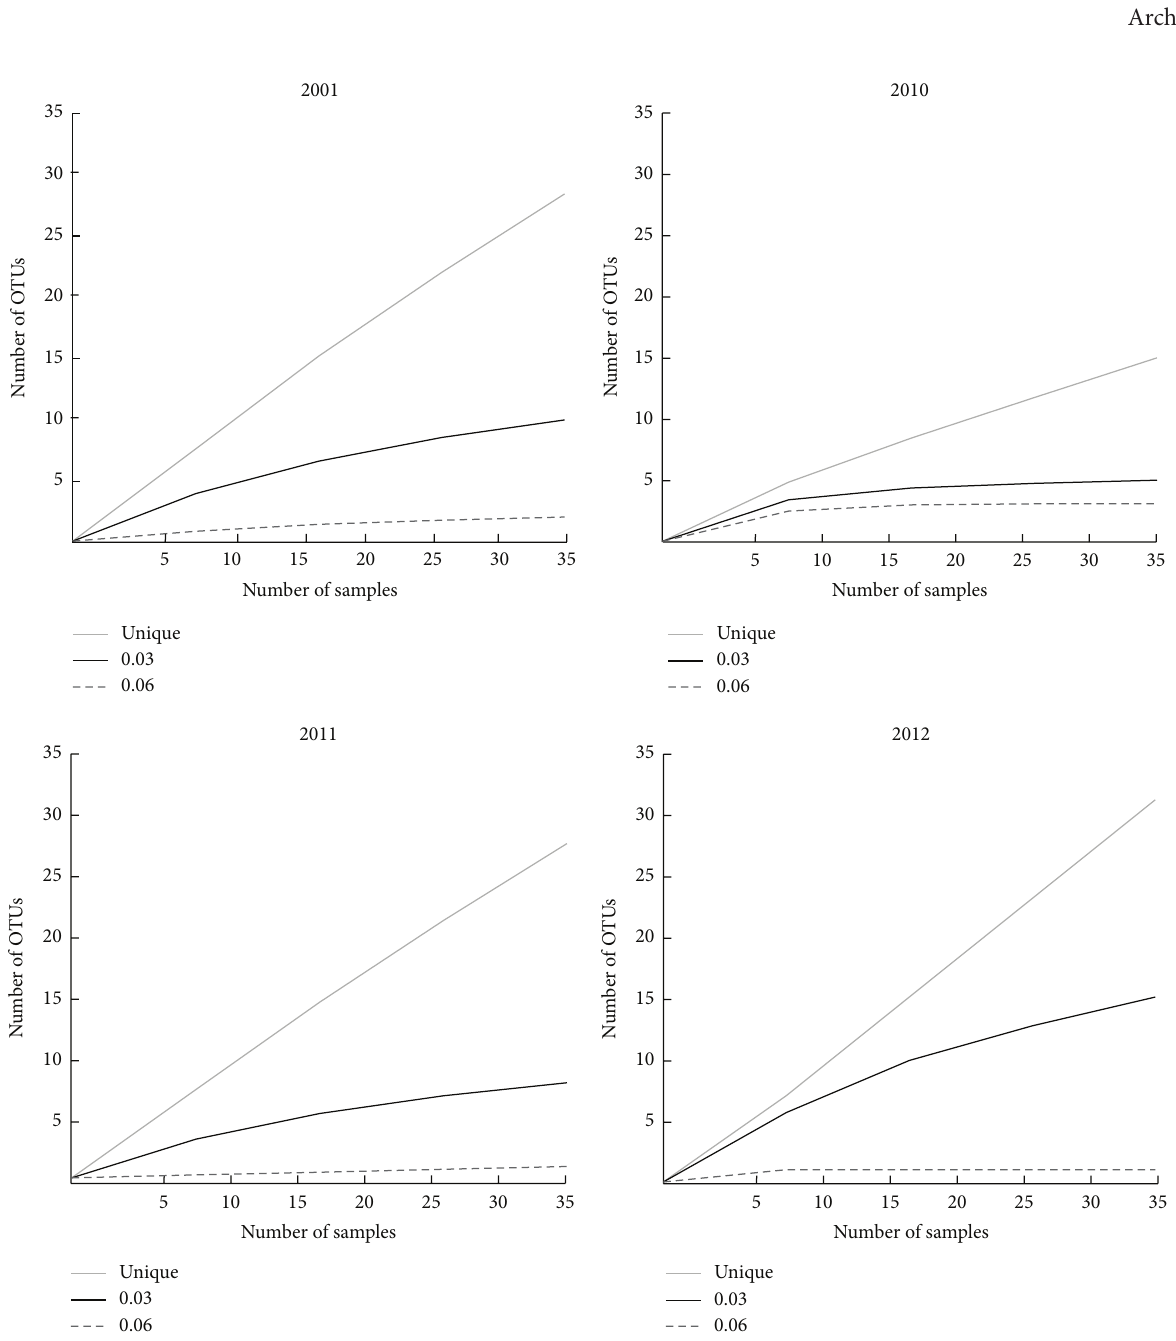
Figure 3: Rarefaction curves of 16S rRNA gene clone libraries from Stone’s Pocket. The y -axis is number of different OTUs, and the x -axis is number of sampled